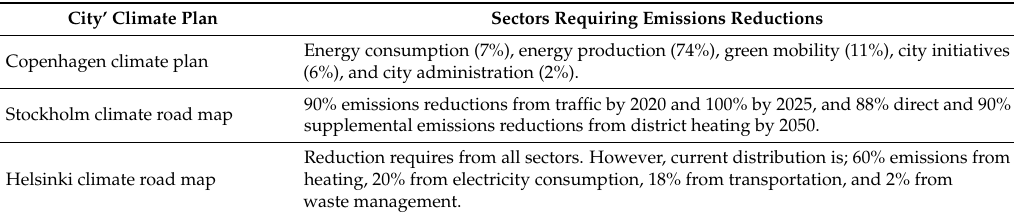
Table 3. Cities emission reduction targets in their climate plans